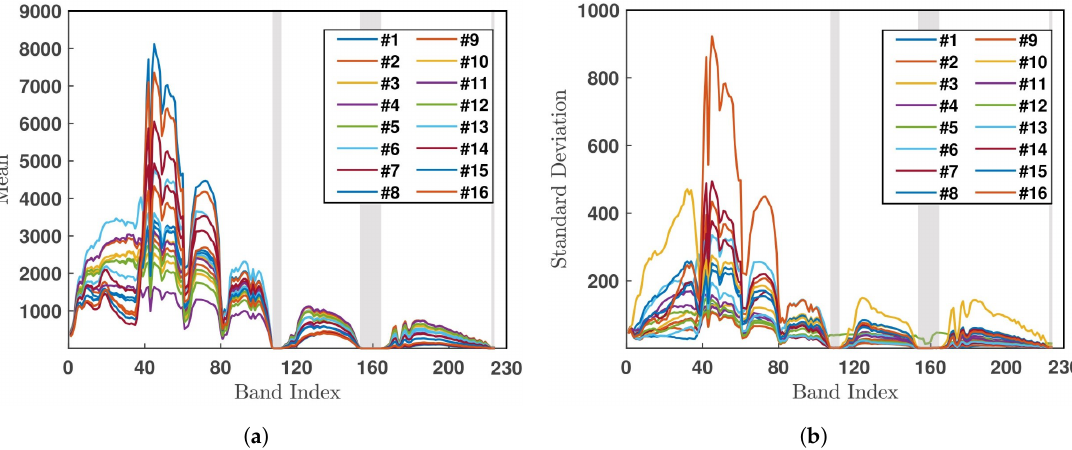
Figure 15. ( a ) Mean value and ( b ) standard deviation of all the pixels in each of the 16 classes, over all 224 bands in Salinas Valley HSI.